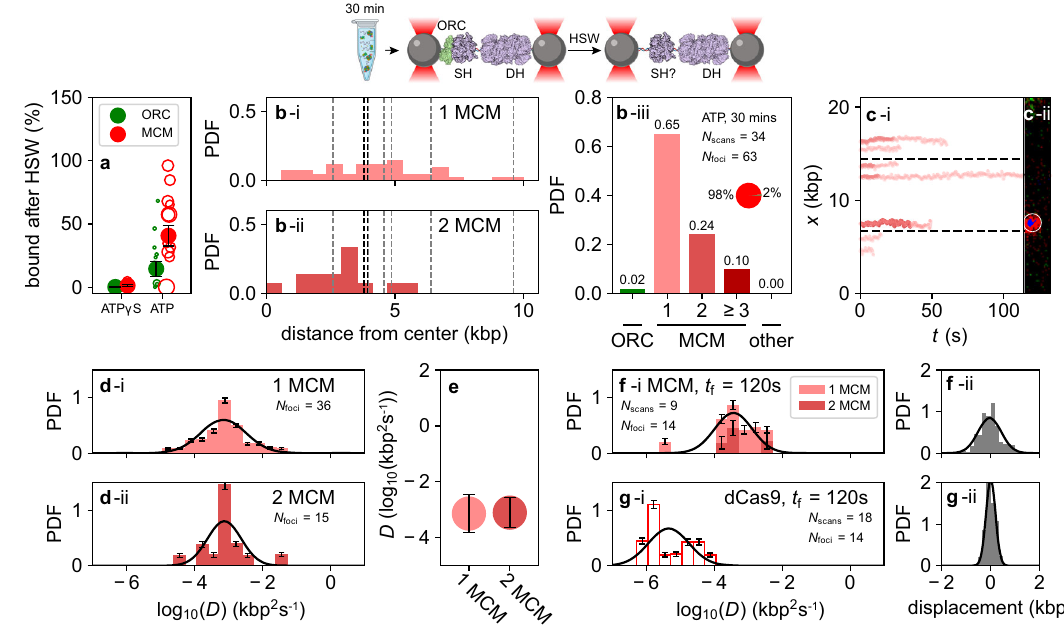
Fig. 4 Spatial distribution, stoichiometry, and diffusive behavior of MCM in ATP after HSW. a The fraction of ORC and MCM complexes that survive an in-situ HSW following incubation in ATP γ S (left) or ATP (right). Percentages are the ratio of the total fl uorescence of ORC (green) or MCM (red) before and after the HSW. Open circles are individual measurements, while the fi lled dots and error bars are the sample mean and S.D., respectively. In ATP γ S (green), N = 6, whereas in ATP, N = 11. b (i – ii) The spatial distributions of the fl uorescent foci, and (iii) the overall stoichiometry distribution. The gray bin labeled “ other ” accounts for all foci with ORC or MCM stoichiometries higher than 3. c Images and sample time traces that illustrate the motion of foci initially containing one (light red) or two (red) MCM. d Histograms of the diffusion constants of foci containing a single MCM (i) or two MCM (ii). Log- normal fi ts to the distributions of single (double) MCMs yield mean ± SEM of 0.006± 0.002 kbp 2 s − 1 (0.004 ± 0.001 kbp 2 s − 1 ), taking into account the error bars derived from bootstrapping the data set 100 times. e Summary plot of the diffusion constants derived from the data in d . f (i) Histogram of the diffusion constants of foci containing a single MCM (light red) or two MCM (red) imaged in high-salt buffer at an acquisition frequency of one frame every 120 s. The fi tted diffusion coef fi cient was 0.0023 ± 0.0009 kbp 2 s − 1 (mean ± SEM). (ii) Histogram of the net displacements observed for the same MCM molecules as in (i). g (i) Histogram of the diffusion constants for foci containing dCas9-JF646 imaged in high-salt buffer at the same reduced acquisition ( p < 0.0001). (ii) Histogram of the net displacements observed for the same dCas9 molecules as in